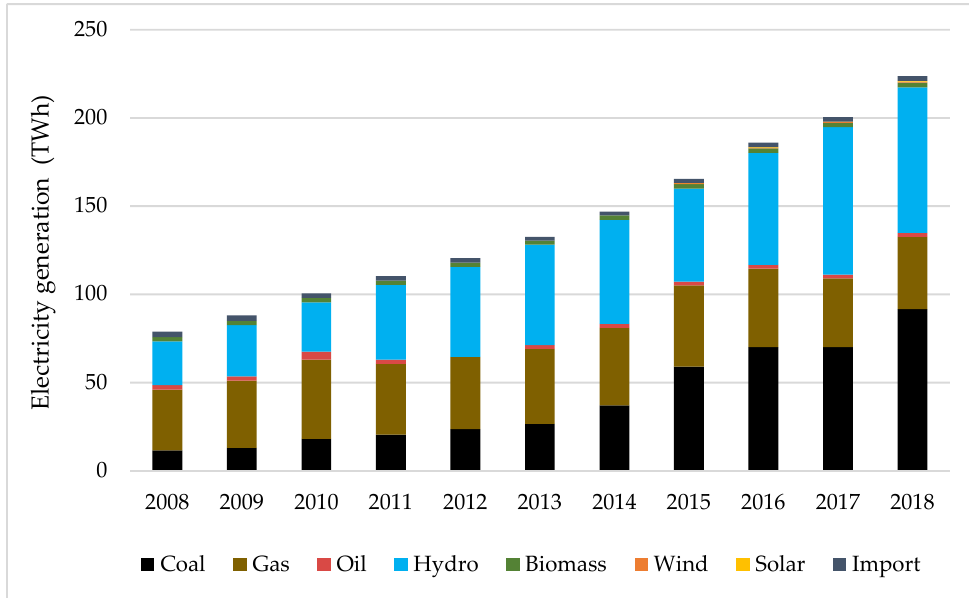
Figure 5. Types of electricity generation in Vietnam in 2018. (Adapted from Refs. [33–35]).